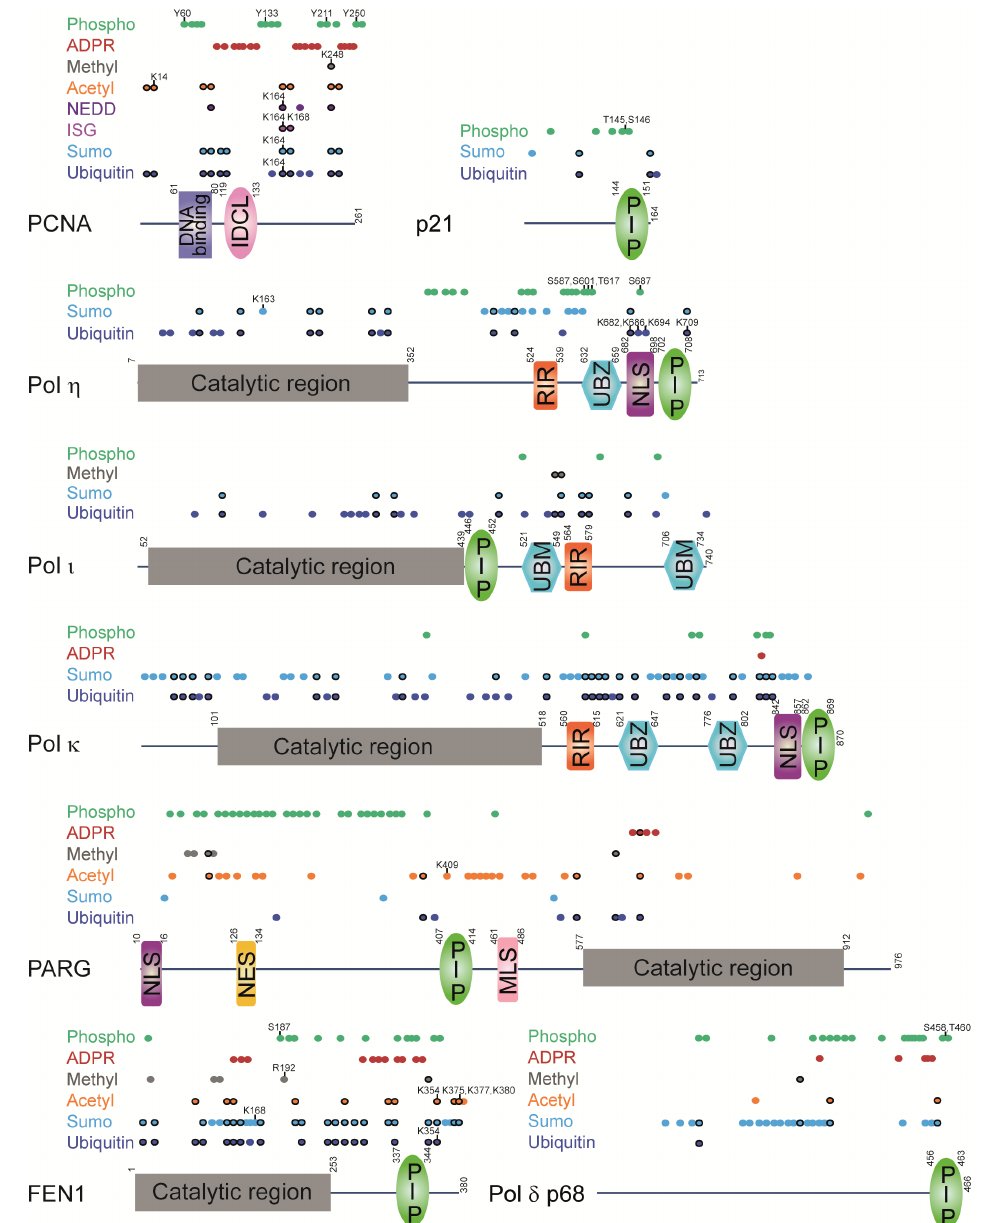
Figure 7. Regulatory regions in PCNA-interacting proteins have PCNA-interacting modules and are modified by different PTMs. PCNA-interacting modules: PIP (PCNA-interacting protein motif); UBZ (ubiquitin-binding zinc finger motif); UBM (ubiquitin-binding motif); RIR (Rev1-interacting region motif). Other modules: IDCL (interdomain connector loop); NLS (nuclear localization signal); NES (nuclear export signal); MLS (mitochondrial localization signal). Colored dots represent modified residues (precise location is given in Supplementary Table S1). Black-circled dots denote overlapping modifications. Dots labelled with numbers indicate residues that were functionally characterized.